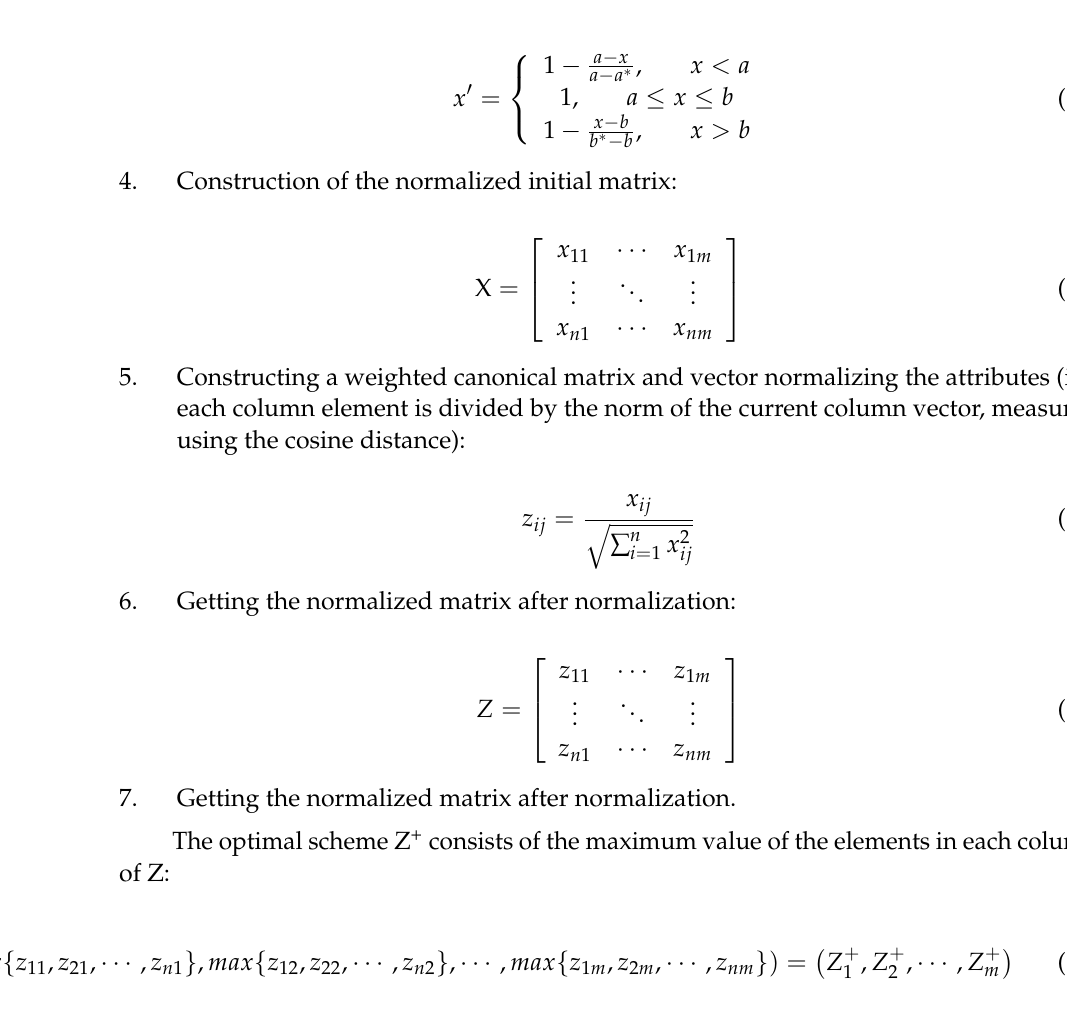
8. The worst solution Z − consists of the minimum value of each column of elements in z: